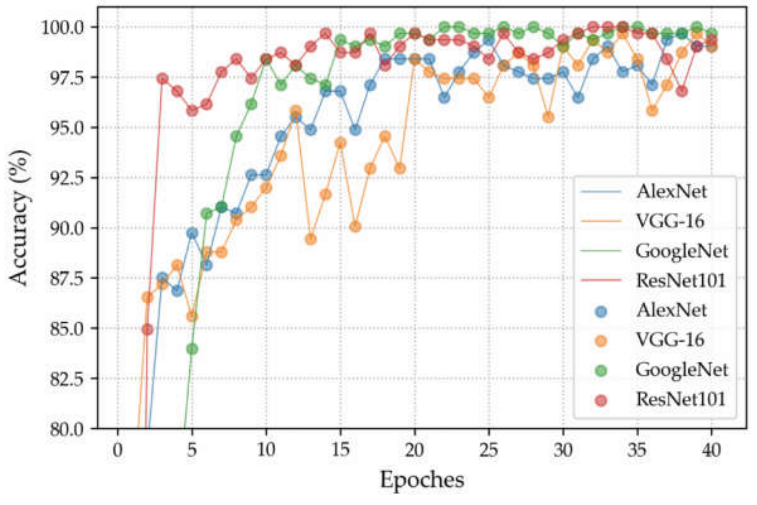
Figure 7. Comparison of the accuracy of train dataset among CNN models.